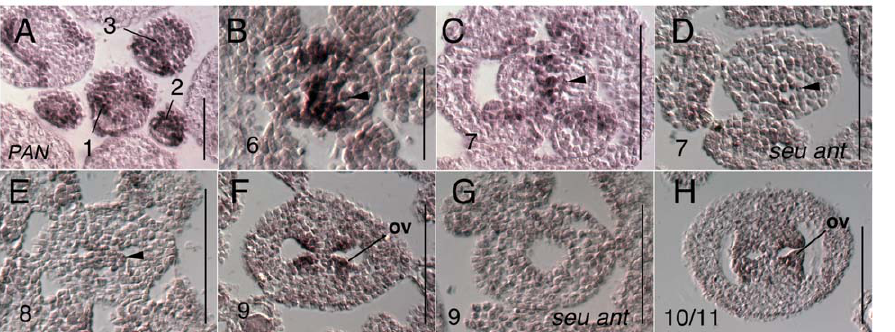
Figure 8. Results of insitu hybridization with PAN antisense probe. Numbers indicate floral stages. All panels show transverse (cross sectional) tissue orientation. Arrowheads indicate medial domain expression. ov - ovule; Scale bars in all panels are 100 microns, except for panel B - scale bar is 50 microns. All panels are Col-0 wild type tissue except as otherwise noted.